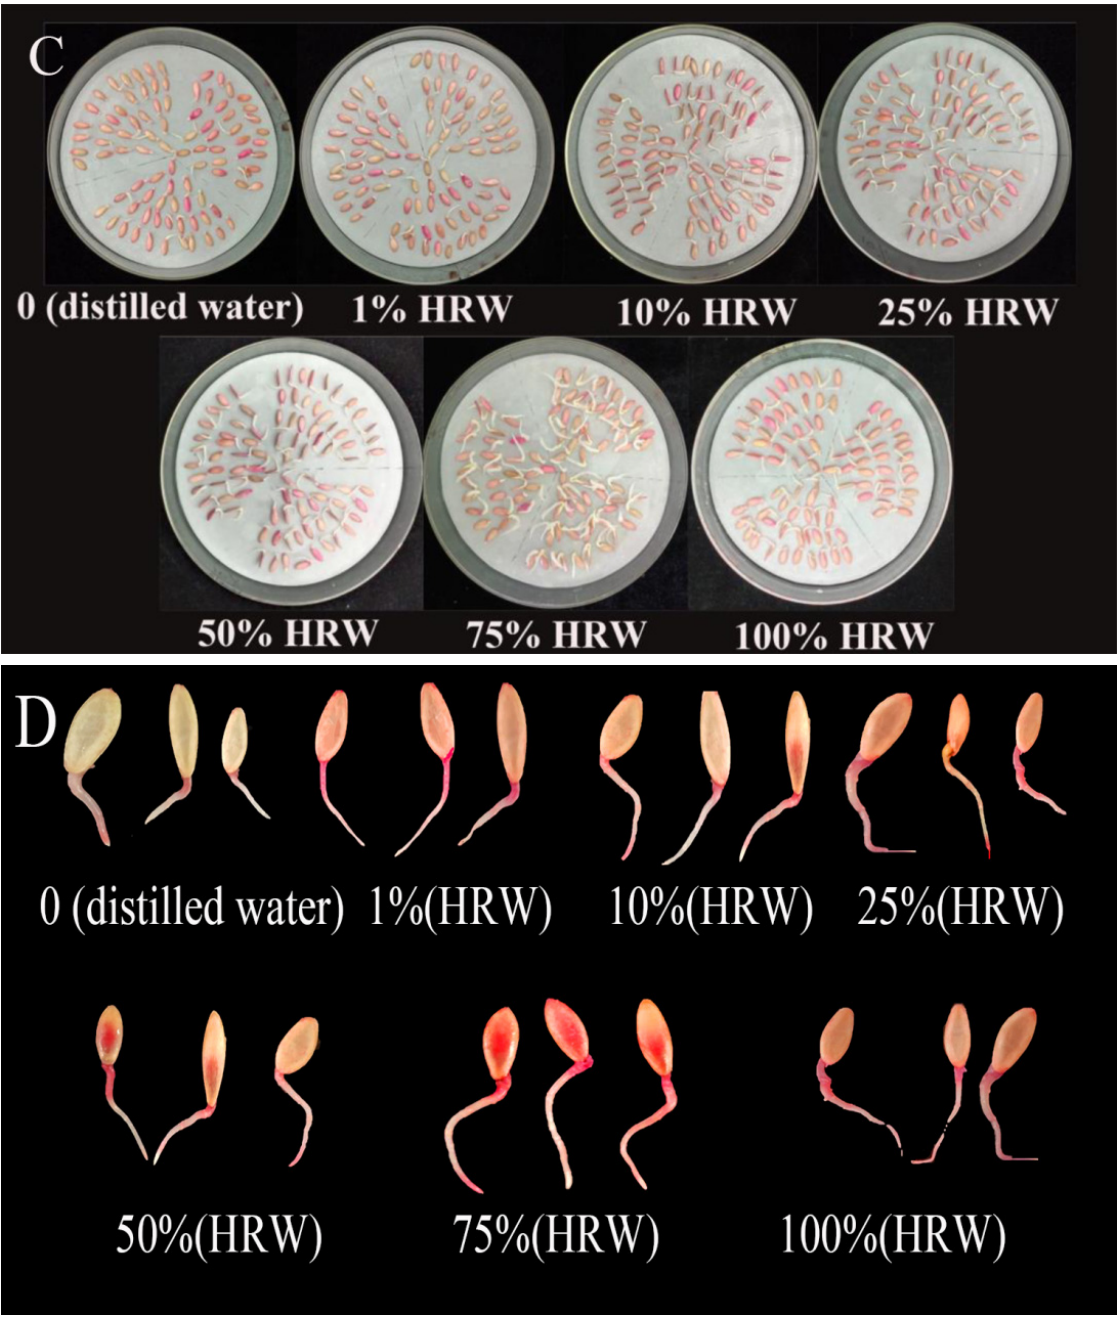
Figure 1. Changes in the germination rate and germ length ( A ), germination index and activity index ( B ), and seed vitality ( C , D ) in cucumber with different concentrations of HRW at 48 h. The seed vitality was determined by TTC solution ( D ); the darker the red, the stronger the seed vitality. The concentrations of HRW were 0, 1, 10, 25, 50, 75, and 100%. The error bars denote the standard errors (n = 3). The different uppercase letters (A–D) above the black columns in ( A , B ) indicate significant differences ( p < 0.05) of germination rate and germination index, and the different lowercase letters (a, b, c, and d) above the white columns in ( A , B ) indicate significant differences ( p < 0.05) of germ length and vitality index according to one-way ANOVA and Tukey–Kramer’s multiple range test. HRW: hydrogen-rich